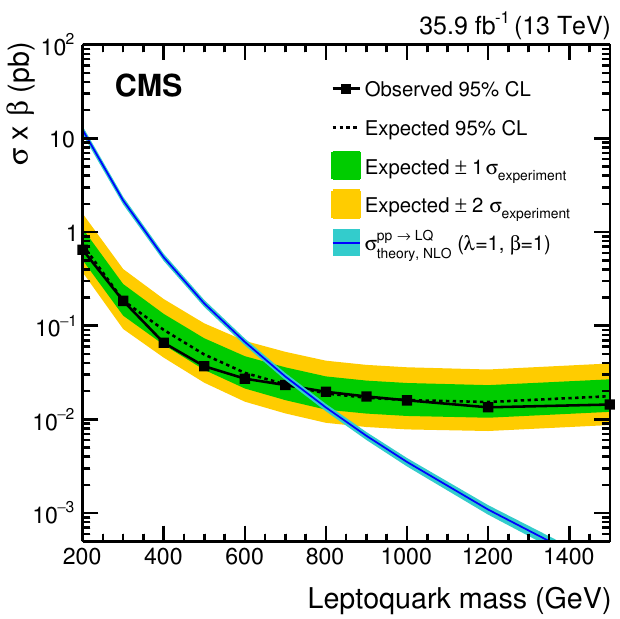
Figure 4 . Observed (black solid) and expected (black dotted) limits at 95% con(cid:12)dence level on the product of cross section (cid:27) and branching fraction (cid:12) , obtained from the combination of the e (cid:28) h , (cid:22)(cid:28) h , and (cid:28) h (cid:28) h signal regions, as well as from the e (cid:22) control region, as a function of the LQ mass. The green and yellow bands represent the one and two standard deviation uncertainties in the expected limits. The theory prediction is indicated by the blue solid line, together with systematic uncertainties due to the choice of PDF and renormalization and factorization scales [45], indicated by the blue